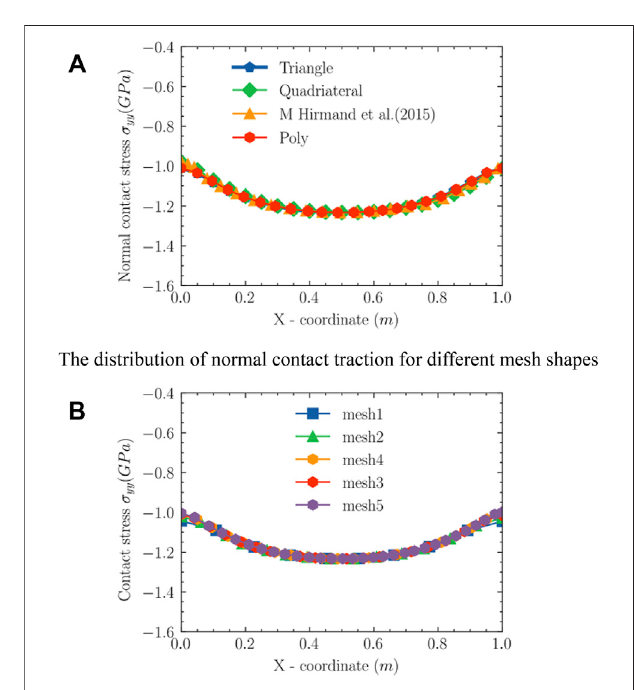
FIGURE 10 | The distribution of normal contact traction in horizontal contact interface. (A) The distribution of normal contact traction for different mesh shapes. (B) The distribution of normal contact traction for different number